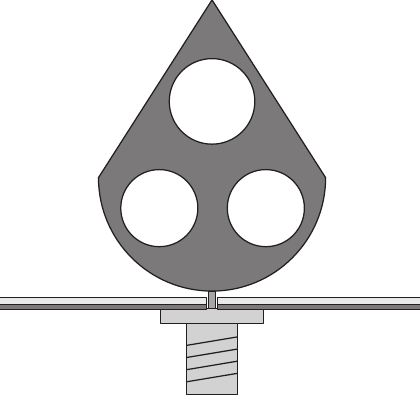
Figure 6: The leaf-shaped antenna [24]. The holes in the monopole are used to modify the surface currents distribution giving rise to a more favorable reactive energy configuration near the monopole. Dark gray monopole and medium gray ground